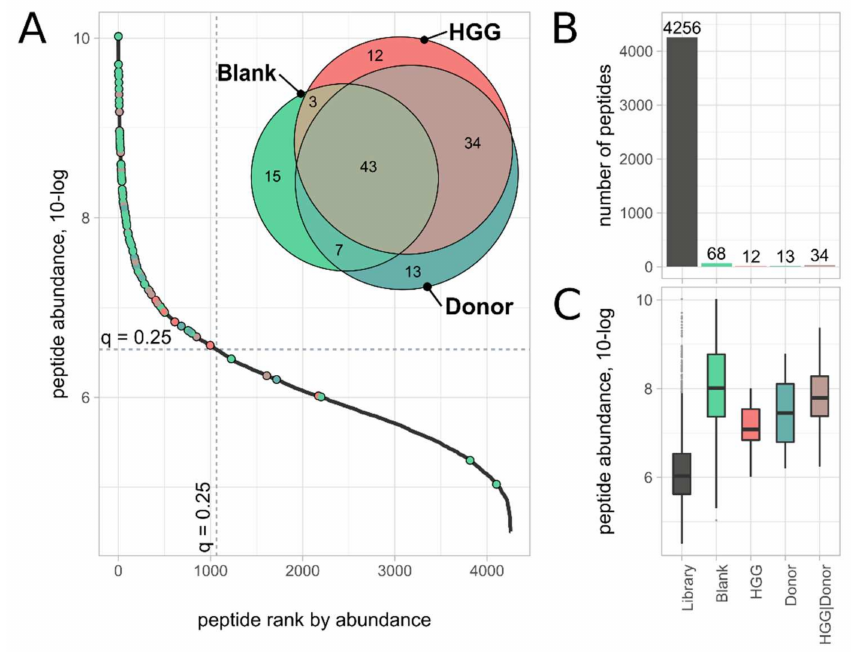
Figure 5. ( A ) Waterfall plot of total peptide library, with (logarithmic) peptide abundance plotted against the peptide abundance rank; peptides identified using shotgun proteomics in the blank sample (Avastin), HGG plasma or donor plasma samples are marked as points, with a color corresponding to the originating sample. Dotted horizontal and vertical lines show the abundance level (6.54) and rank (1065), respectively, of the top peptide abundance quartile. The Venn diagram insert shows the originating sample of the 127 peptides. ( B ) Bar chart of number of peptides identified in the peptide library (gray) and the Ab-binding fraction of an Avastin blank (including peptides that were found in blanks and other samples), donor plasma, HGG plasma and in both, HGG and donor plasma. ( C ) Box-plot of peptide abundances (10-log transformed) of the sets of peptides specified in panel